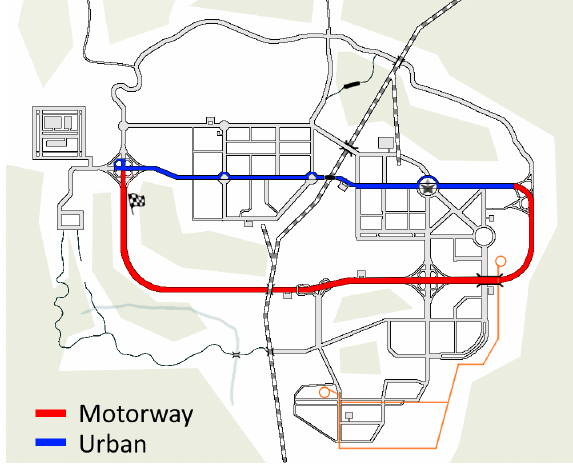
Figure 10. City map of the driving experiments; red line represents the motorway, blue line represents urban streets and checkered flag represents the start and the stop of experiments.